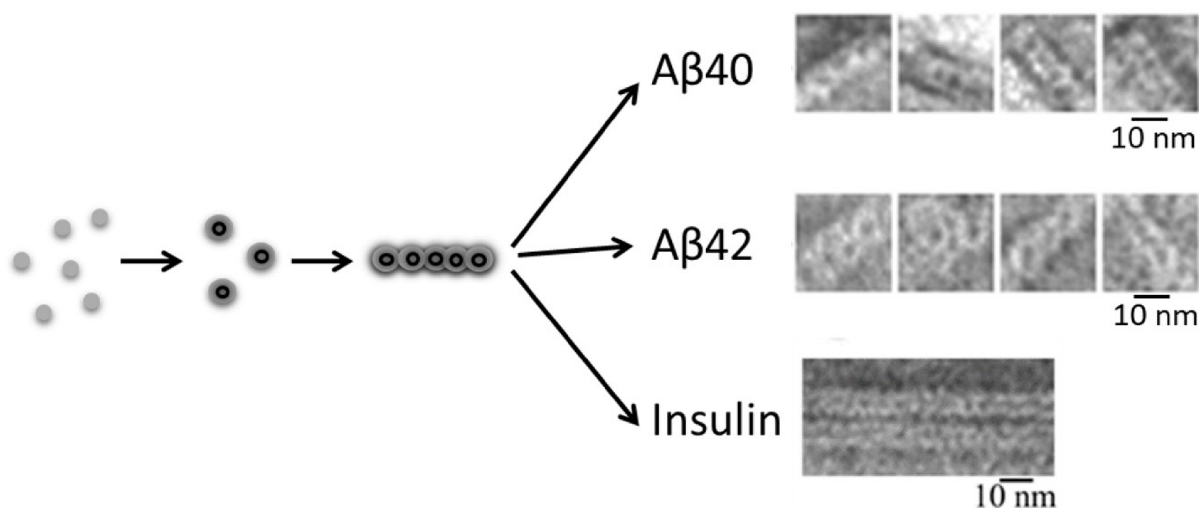
Figure 5. Schematic representation of the process of fibril formation by the recombinant A β (1–40), A β (1–42) peptides and insulin. A β (1–40) and A β (1–42) fibrils are formed under conditions of 50 mM Tris-HCl (pH 7.0–7.2) [16] and insulin at 37 ◦ C, 20% acetic acid (pH 2.0), 140 mM NaCl [31]. The main structural element of insulin fibrils is a ring-like oligomer of about 6–7 nm in diameter, about 2–3 nm in height and about 2 nm in diameter of the